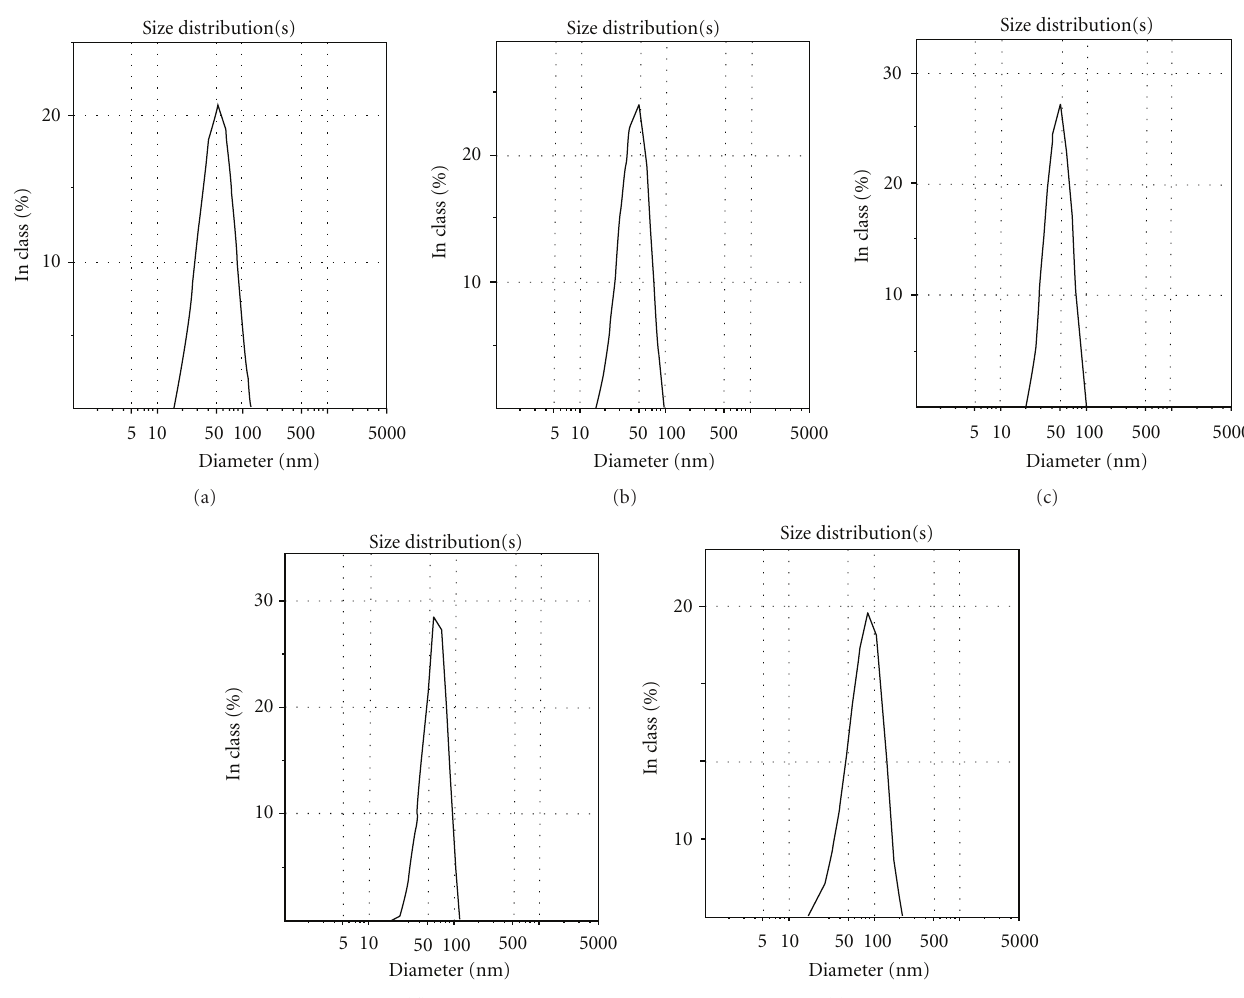
Figure 5: Particle size distributions of curcumin-loaded lipid nanoemulsions in formulations 1(a), 5(b) to